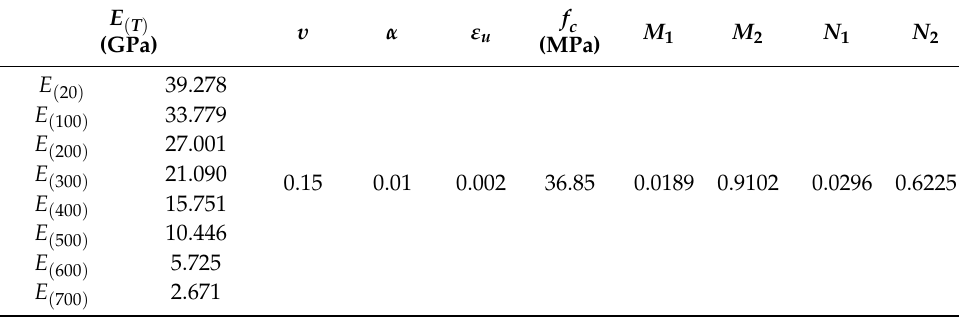
Figure 7. Finite element calculation model of axially compressive concrete column. Table 3. Constitutive model parameters for the